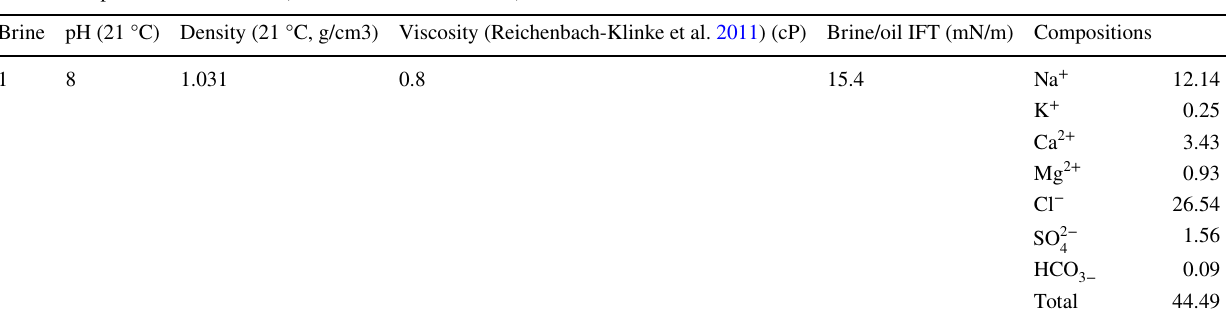
Table 3 Properties of the brine 1 (Standnes and Austad 2000)